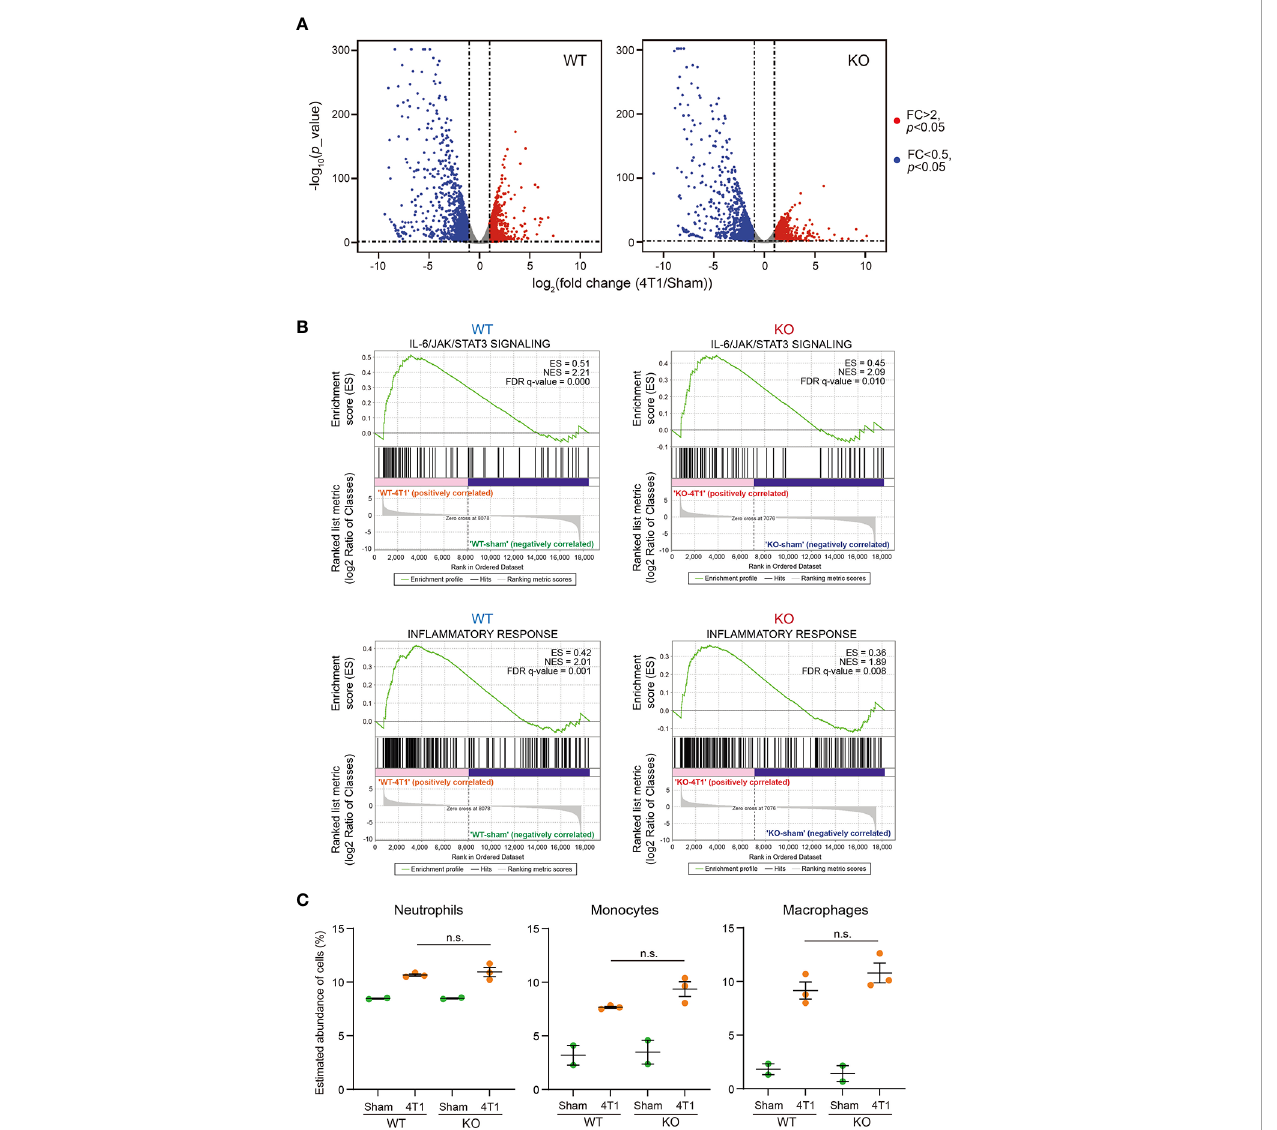
FIGURE 5 Dispensable roles of SAA1-2 in 4T1-induced transcriptomic changes in the bone marrow (A) RNA-seq experiments for the bone marrows of sham- operated mice and 4T1-bearing mice in WT and Saa1-2 KO (14 days after 4T1 transplantation). Volcano plots (log 2 (fold change (4T1/Sham)) versus – log 10 ( p value)) of WT (left) and Saa1-2 KO (right) are shown. Genes showing more than 2-fold change with p < 0.05 are highlighted in red. n = 2 for the sham groups and n = 3 for 4T1-bearing groups. See also Figure S5 for qPCR analyses using the different cohorts of 4T1 transplantation experiments. (B) GSEA plots that evaluate gene expression changes in the bone marrow in “ IL-6/JAK/STAT3 signaling ” and “ In fl ammatory response ” upon 4T1 transplantation in WT and Saa1-2 KO. FDR q value, enrichment score (ES), and normalized enrichment score (NES) are shown. (C) Dot plots showing the estimated abundance of the indicated immune cell types in the bone marrows of sham and 4T1-bearing mice. The scores are calculated using the RNA- seq dataset in (A) and ImmuCellAI-mouse. Data are presented as the mean ± SEM. The p value is shown (unpaired two-tailed Student ’ s t -test). n.s., not signi fi cant, unpaired two-tailed Student ’ s t